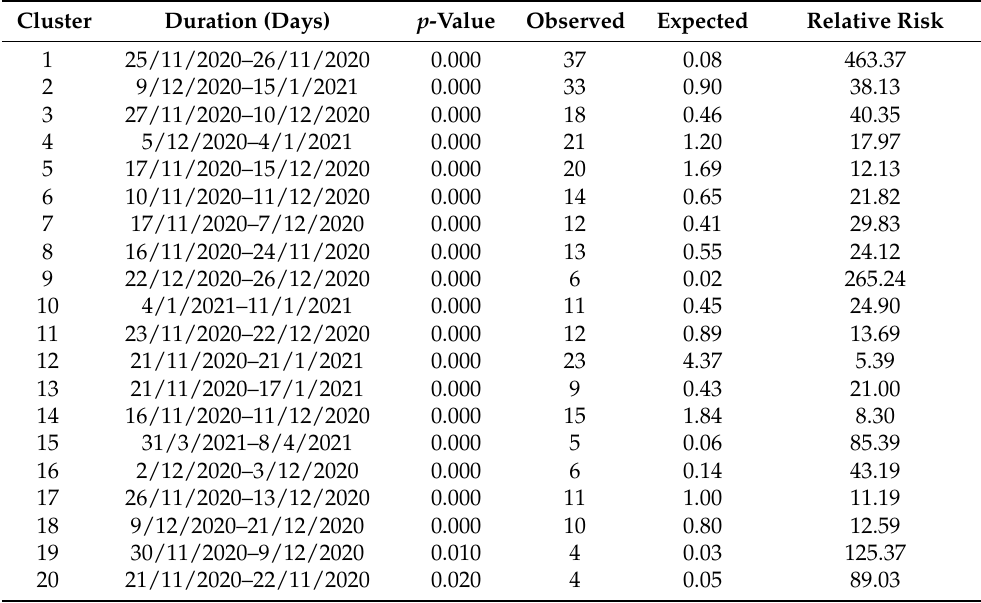
Table 5. Space–time clusters in stage III of COVID-19 transmission in residential locations in Hong Kong. Cluster Duration (Days) p -Value